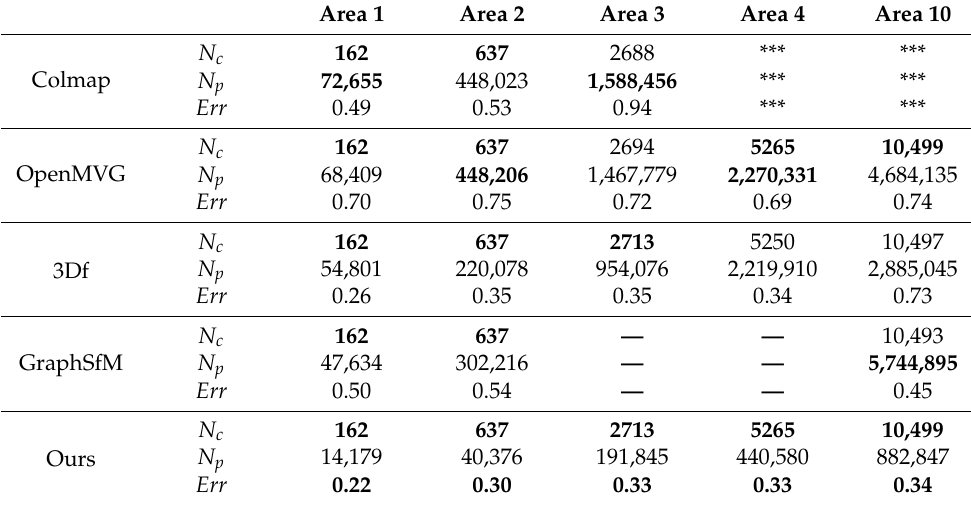
Table 6. Oblique photography dataset accuracy statistics. ( N c : number of registered images; N p : number of structure points; Err : reprojection error (MSE), in pixels; — represents reconstruction failure; *** represents the reconstruction time is more than fifteen